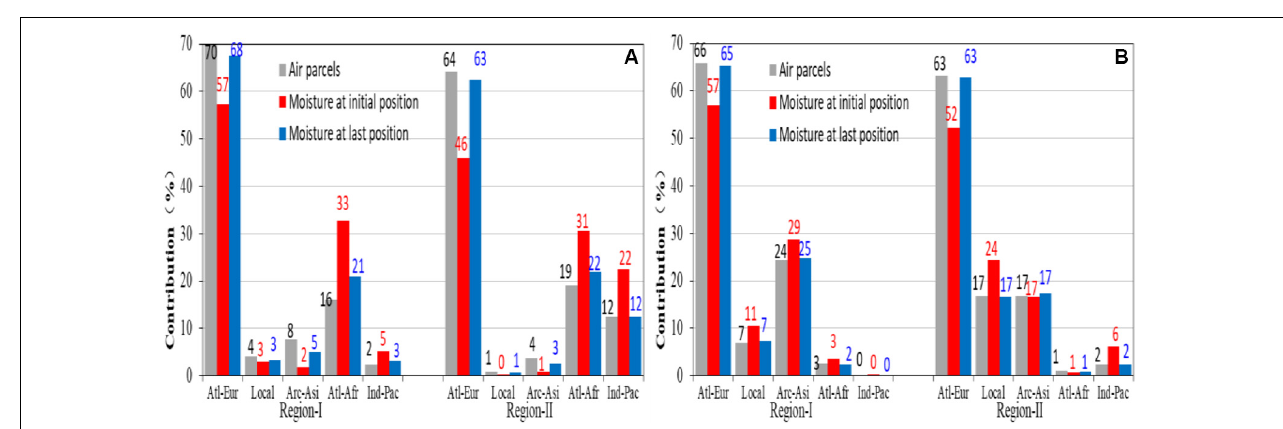
FIGURE 5 | Partition of the sources of water vapor in regions I and II in Central Asia.